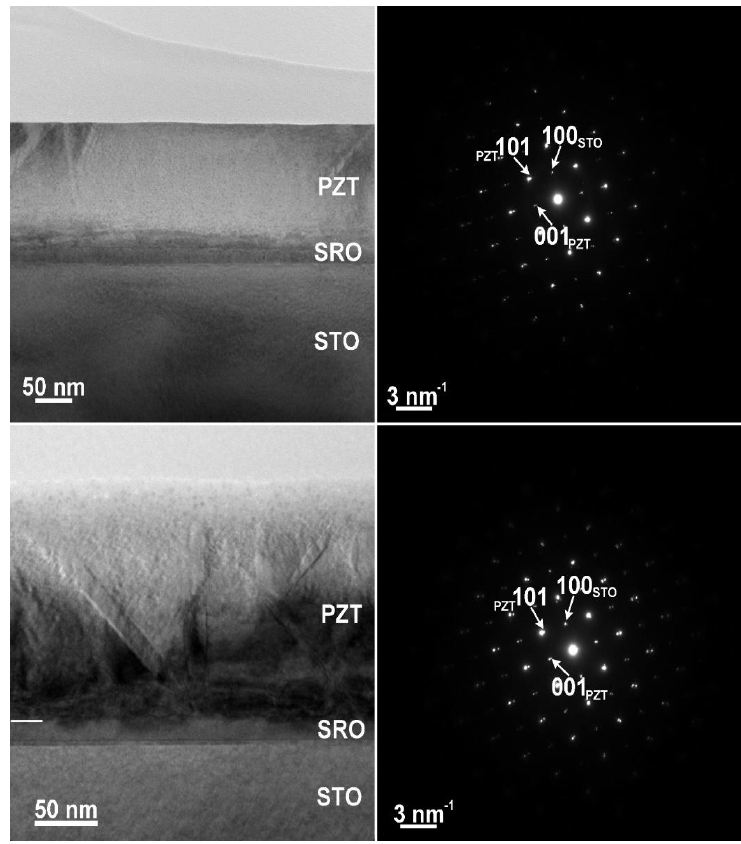
Figure 2. Upper-line: PZT layer grown from the commercial target (PZT-CO); lower-line: PZT layer grown from the in-house manufactured target (PZT-IH).